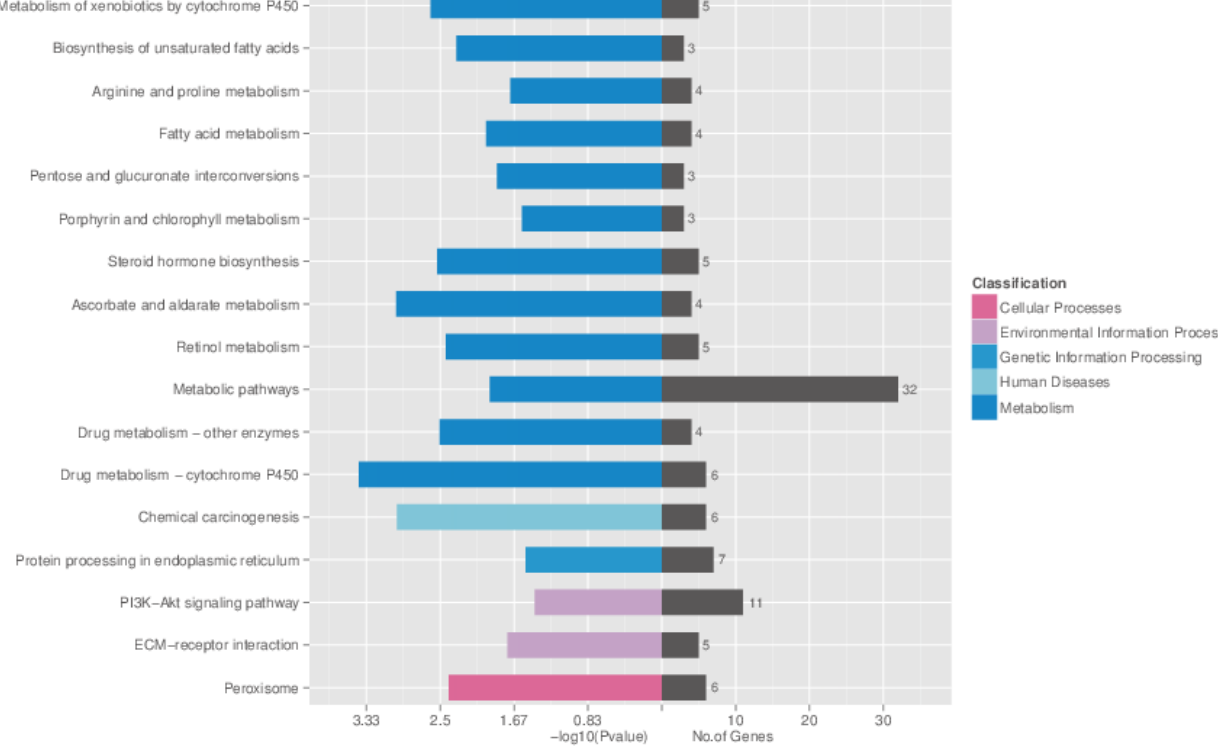
Figure 4. The Kyoto encyclopedia of genes and genomes (KEGG) pathway enriched for targets of the differentially expressed circular RNAs related to host